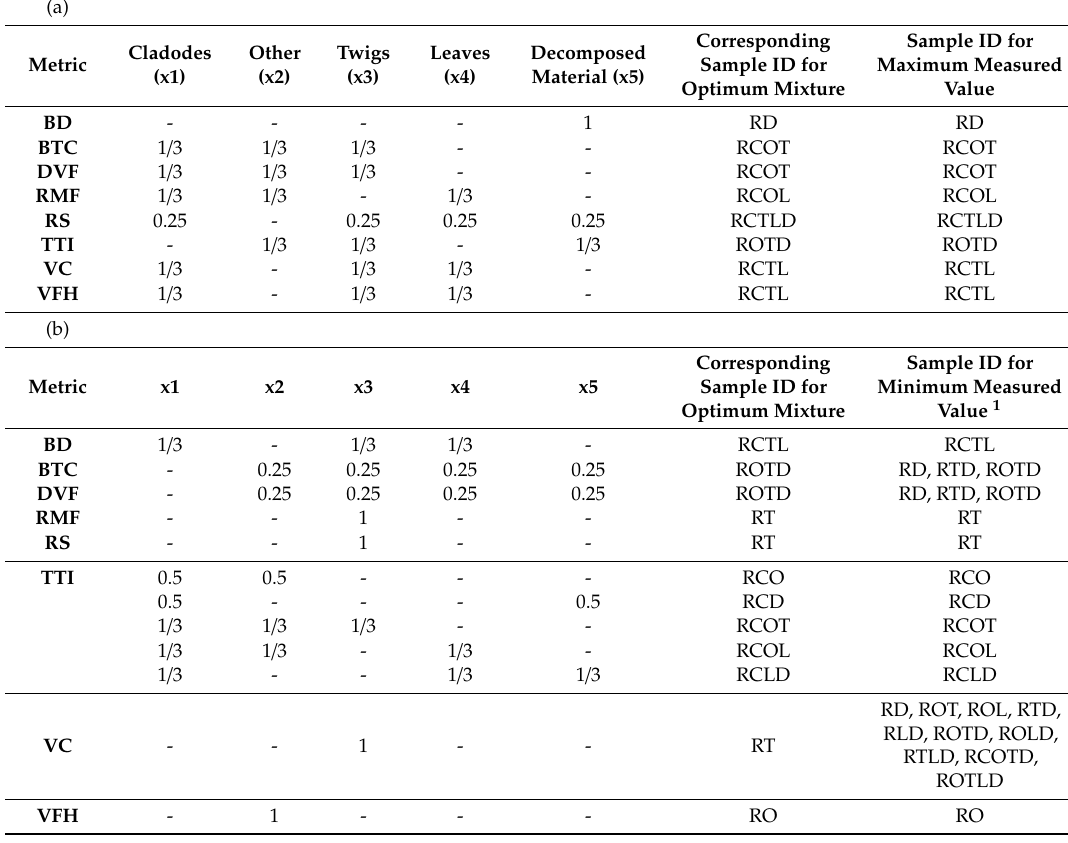
Table 9. Optimisation of the ideal mixture for (a) maximum and (b) minimum flammability for litter from Rofe Park for bulk density (BD), burn to completion (BTC), duration of visual flaming (DVF), residual mass fraction (RMF), rate of spread (RS), time-to-ignition (TTI), volume consumed (VC), and vertical flame height (VFH). Values represent the proportion of each litter component within a mixture. Key to flammability mixtures for litter from Rofe Park (R): Allocasuarina littoralis cladodes (C), other (O), twigs (T), leaves (L), decomposed material (D). 1 Only if the mixture